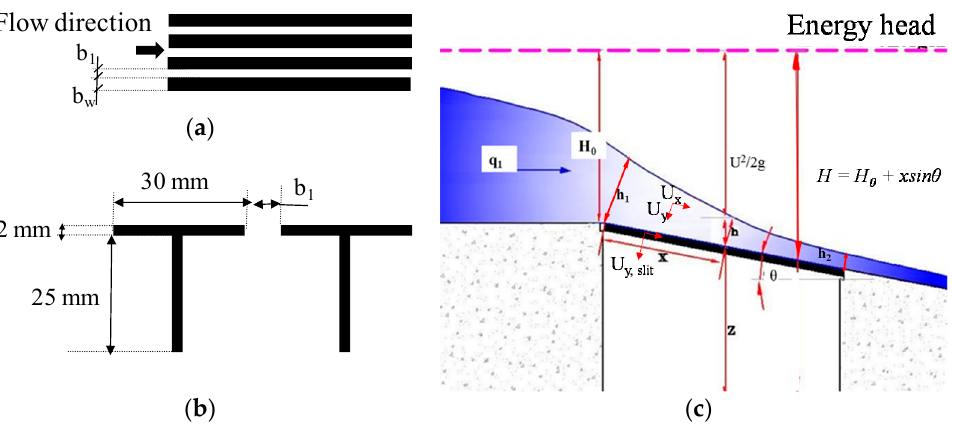
Figure 2. Bottom intake system: ( a ) Top view of the rack; ( b ) frontal view of the T-shaped bars; ( c ) scheme of the flow over a bottom intake system.